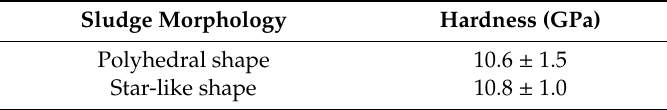
Table 4. Hardness values of sludge particles with different morphology.